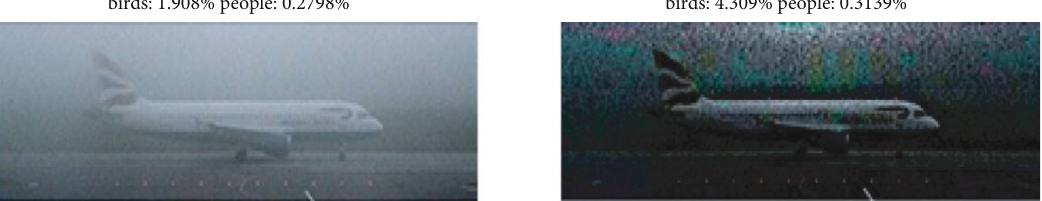
Figure 6: Comparison of image target recognition e ff ect in 2nd picture.